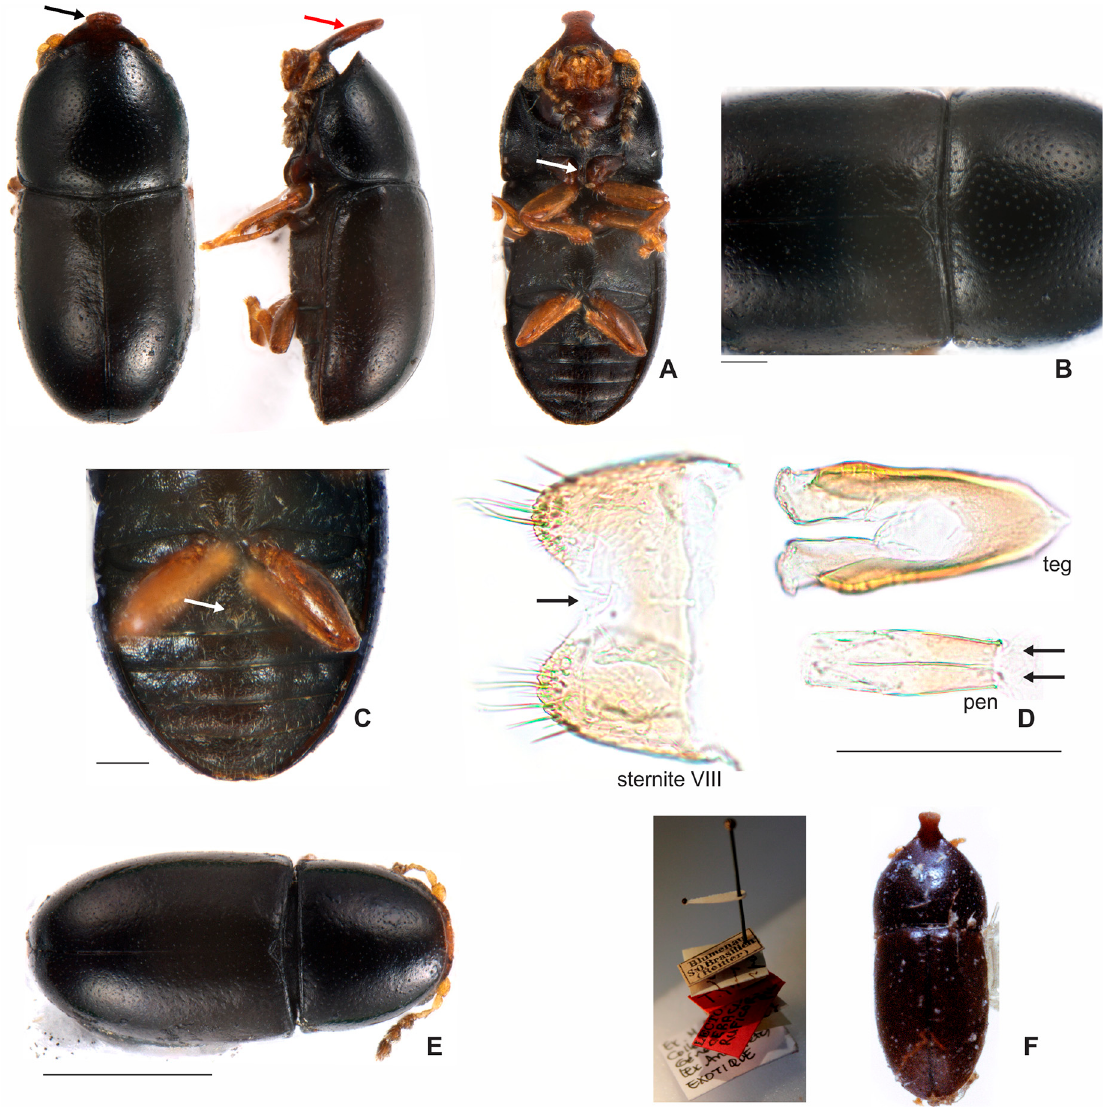
Figure 10. Ceracis ruficornis Pic. A − C Male plesiotype, ( A ) dorsal, lateral and ventral views, respectively. Frontoclypeal ridge strongly produced forming a long horn (black arrow); laminar in lateral view (red arrow); prosternal process thin (white arrow), ( B ) pronotal punctation, ( C ) first abdominal ventrite with a sex patch at the centre (white arrow), ( D ) terminalia of a male from Bertioga, SP, Brazil, showing sternite VIII, with a deep concave emargination at the middle of the posterior edge (arrow), tegmen (teg), penis (pen) with basal edge blunt (arrows), ( E ) female plesiotype from Praia da Boraceia (SP, Brazil), ( F ) male lectotype deposited in the Muséum National d'Histoire Naturelle, MNHN (Paris, France) . Scale bars: A = 0.5 mm, B − D = 0.1 mm, E,F = 0.5 mm.